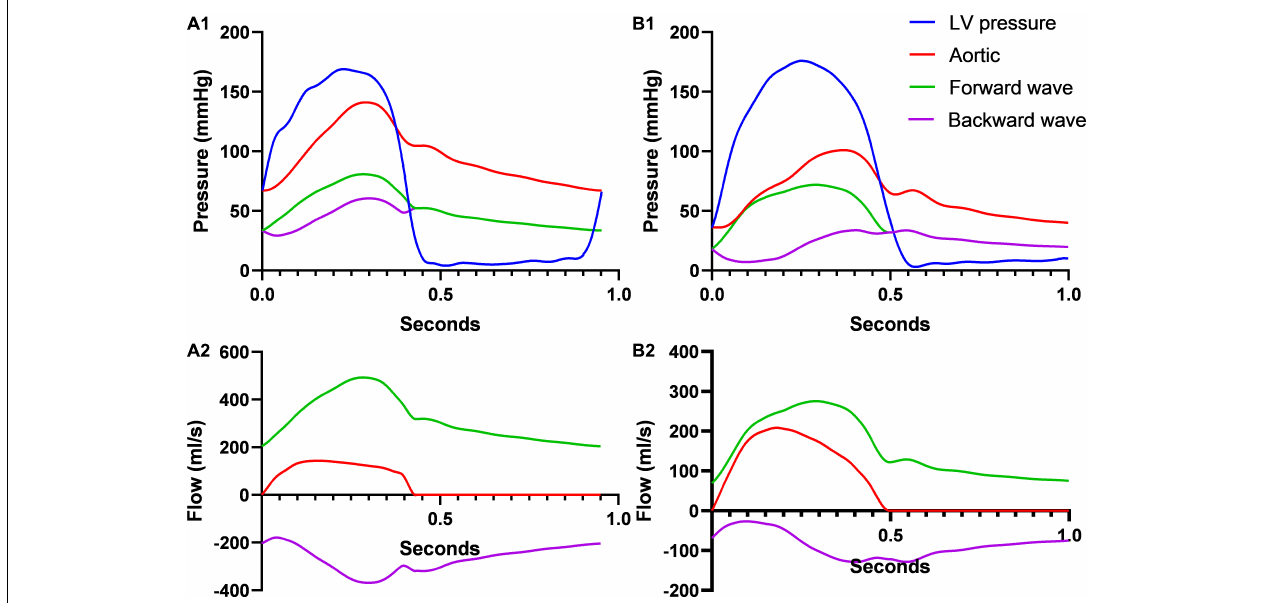
FIGURE 3 | Pressure and flow wave separation analysis for two study participants from the Q1 (A) and the Q4 (B) groups. Pressure and flow wave separation analysis in a patient with an early (transit time 0.041 s, reflection magnitude 66%, panels A1,A2 ) and a late reflection wave arrival (transit time 0.167 s, reflection magnitude 49%, B1,B2 ) with the same AVA (0.55 cm 2 ). Early reflection arrival is associated with a much more prominent deceleration of the aortic flow due to the backward wave and a decreased SV ( A2 vs. B2 , 47 ml vs 68 ml accordingly). In addition, early arrival is associated with increased aortic pressure during systole, with left ventricular pressure being comparable between the two patients ( A1 vs. B1